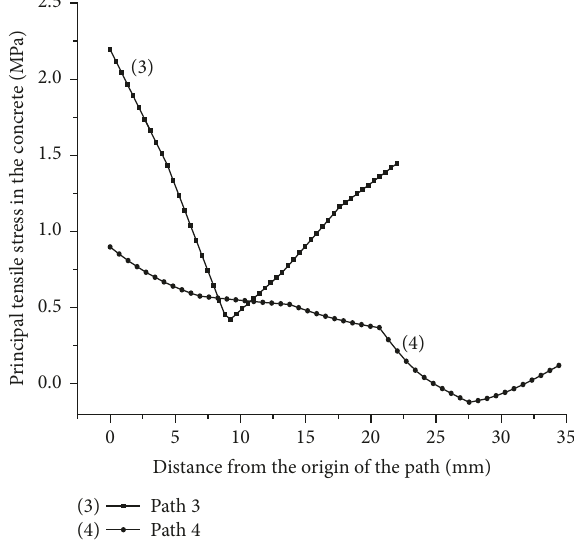
Figure 8: Distribution of the principal tensile stress in the direction perpendicular to the boundary and the direction at an angle of 45 ∘ with the